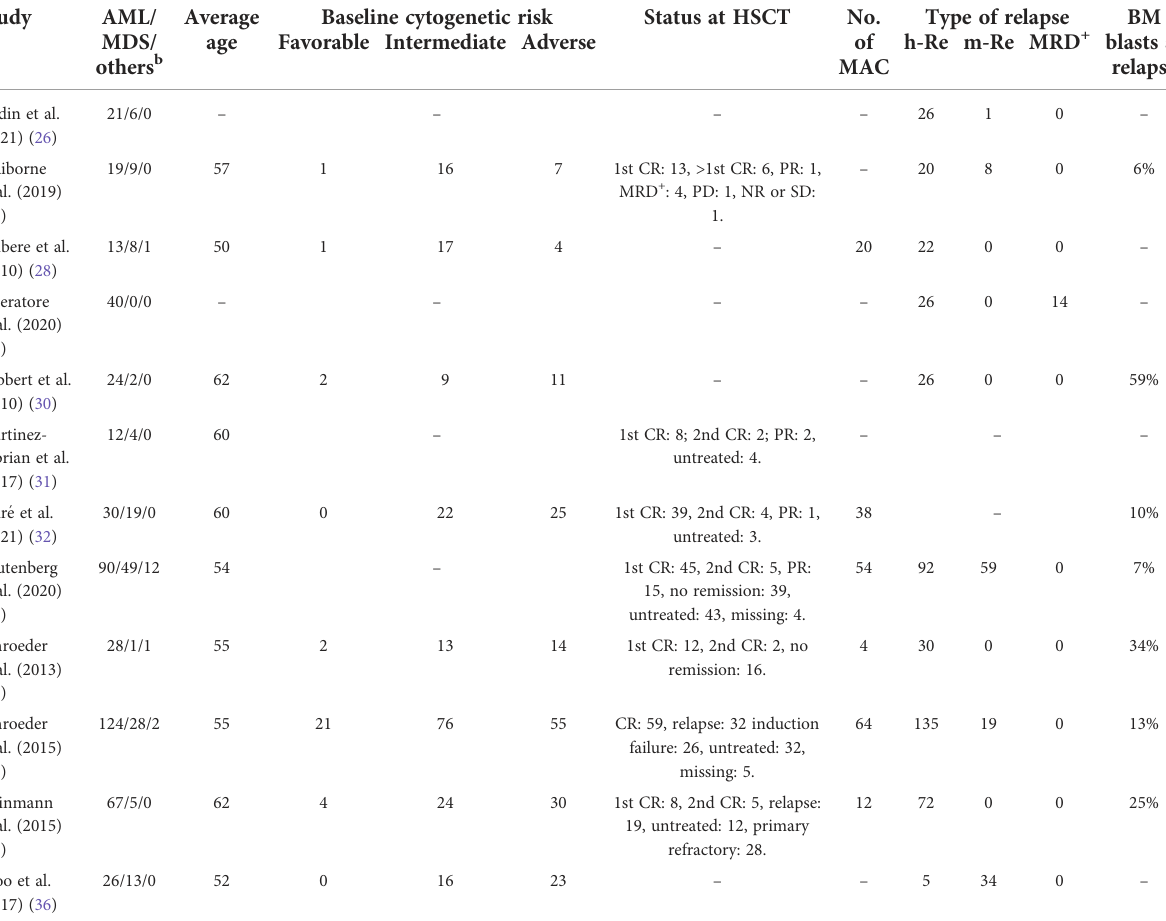
TABLE 2 Baseline characteristics of the included patients a.